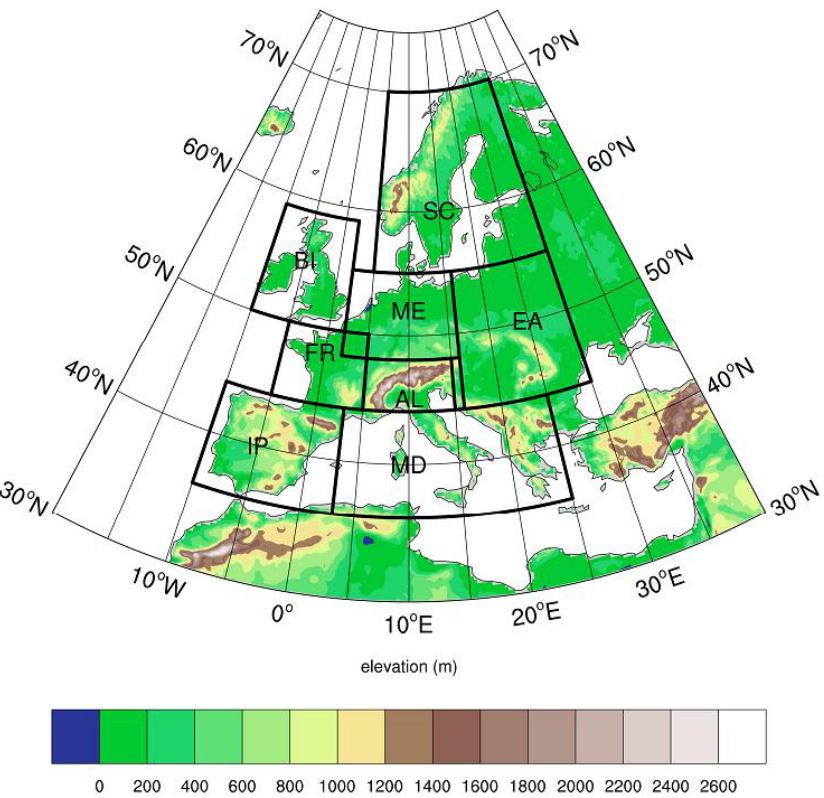
Figure 1. Subdomains based on the Prudence project: the Alps (AL), the British Isles (BI), Eastern Europe (EA), France (FR), the Iberian Peninsula (IP), the Mediterranean (MD), Mid-Europe (ME) and Scandinavia (SC).